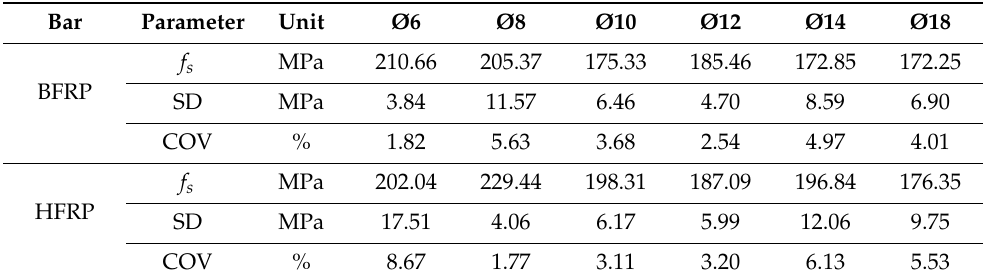
Table 5. Shear strength testing results of FRP bars for di ff erent diameters.